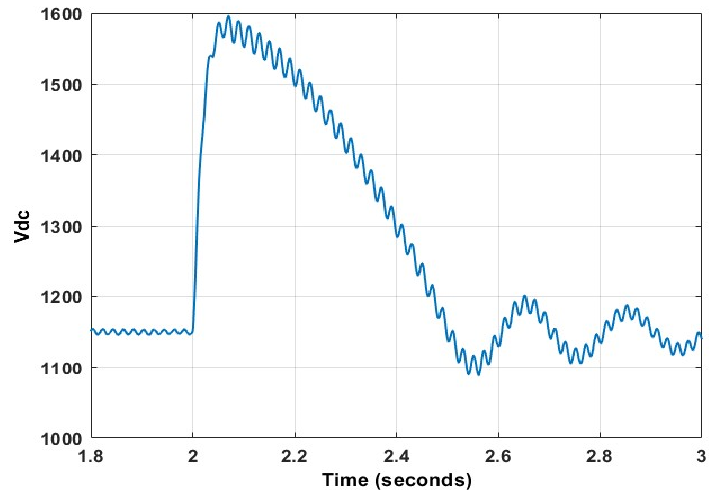
Figure 26. DC voltage transient using DCI at 70% dip.